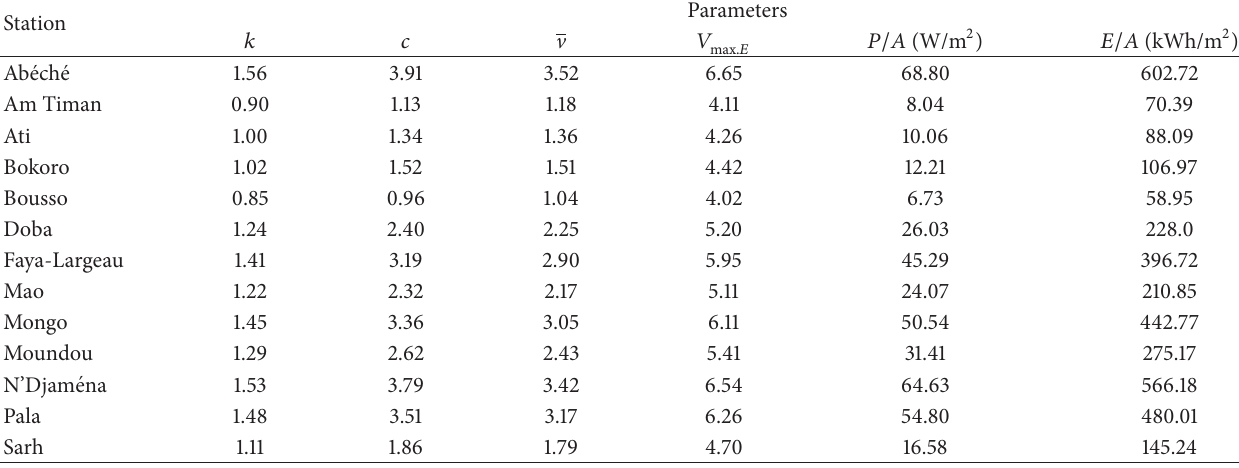
Table 3: Yearly Weibull parameters (𝑘,𝑐) , average wind speed, wind speed carrying maximum energy, wind power density, and wind energy density (at 10m height).